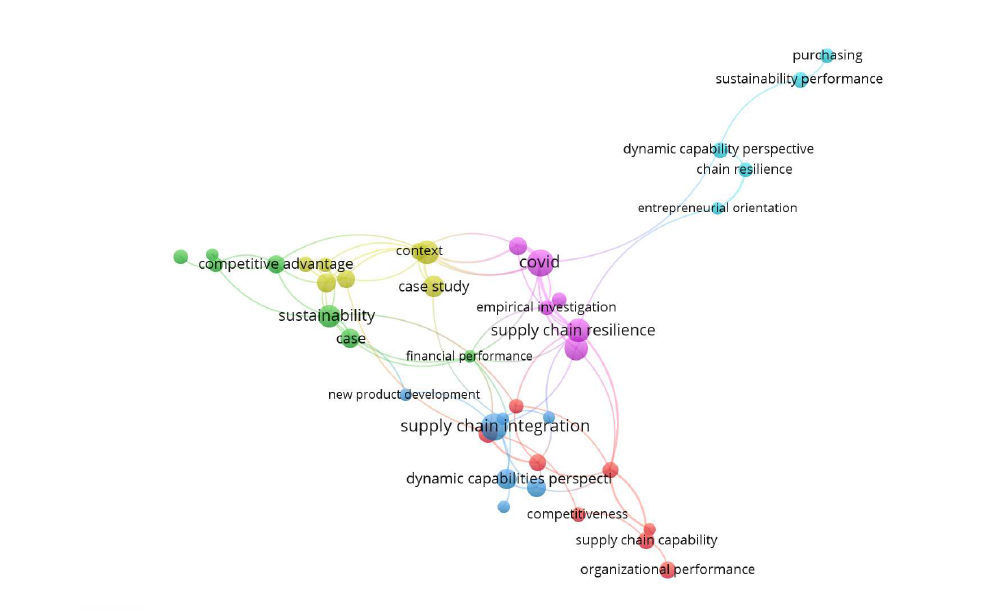
Figure 7. Concepts related to SCDC in Web of